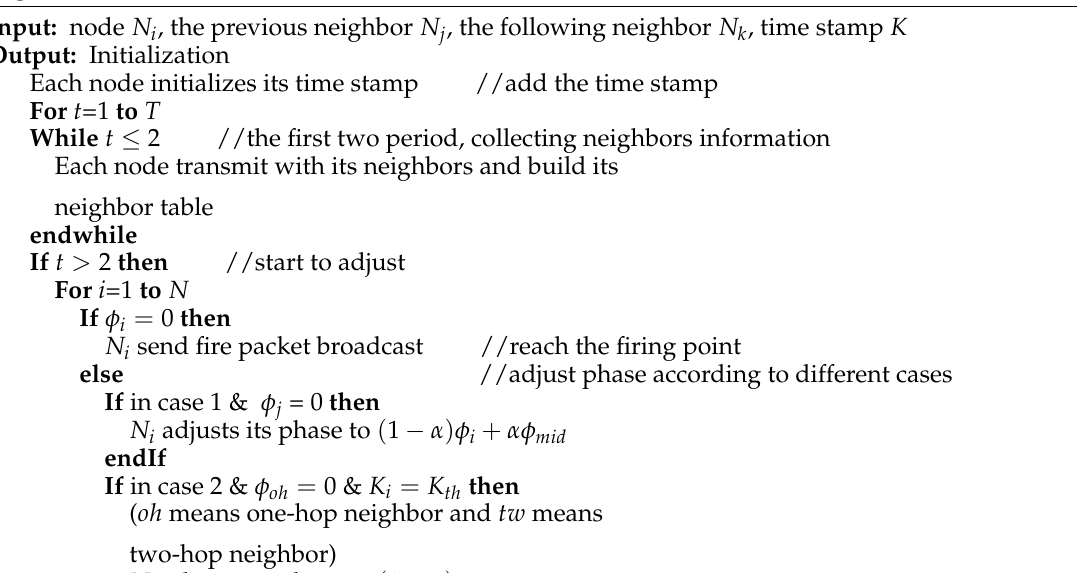
Algorithm 1 The Process of